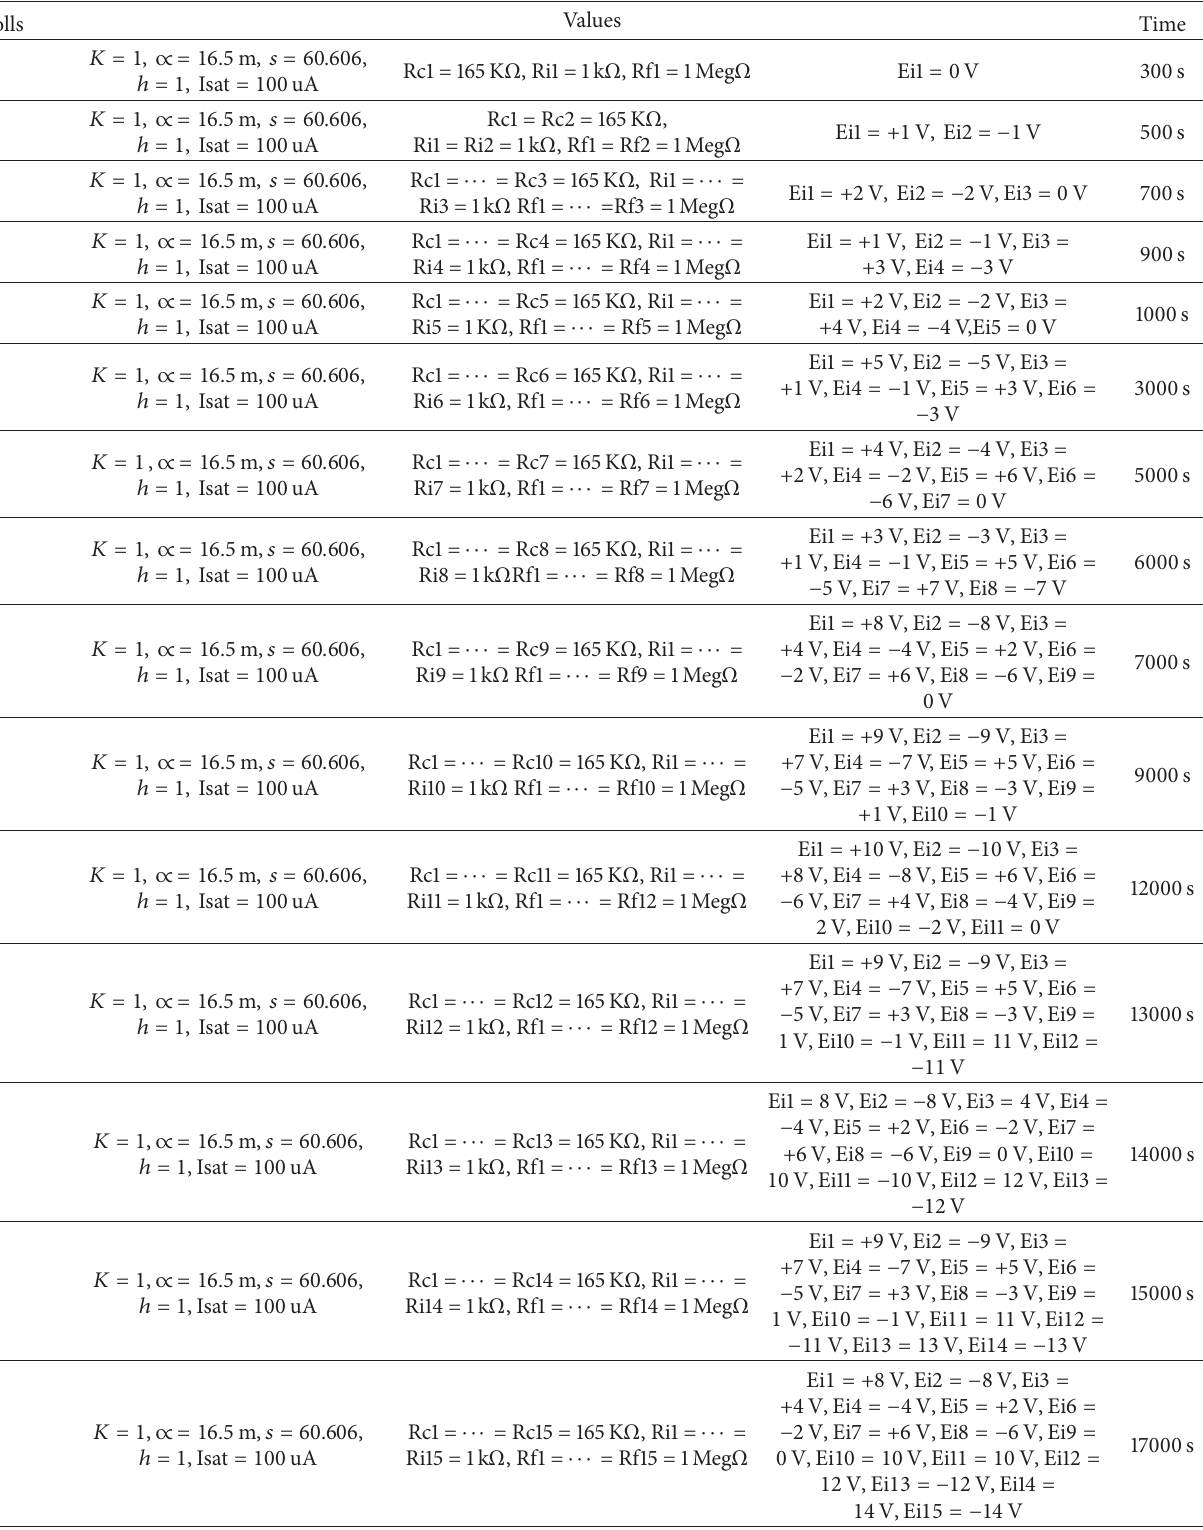
Table 3: Values for generating from 2 to 18 scrolls using